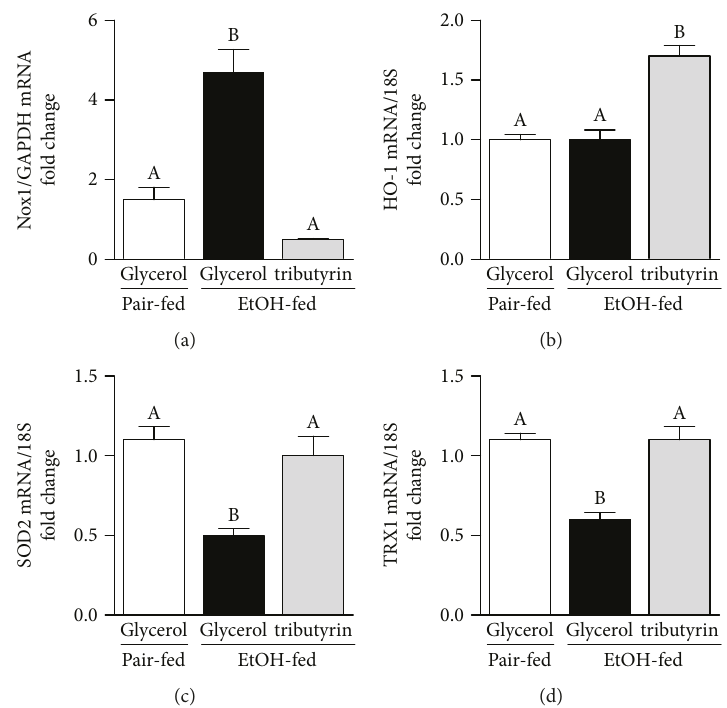
Figure 4: E ff ects of tributyrin on expression of pro- and antioxidant mediators in the proximal colon following chronic-binge ethanol exposure. Mice were treated as described in Figure 1, and the proximal colon was excised and used to prepare RNA. (a – d) Expression of NOX1, HO-1, SOD2, and TRX1 mRNA was detected in the mouse proximal colon using quantitative real-time reverse transcription polymerase chain reaction. Values represent means ± SEM . n = 4 – 6 mice per treatment group. Values with di ff erent alphabetical superscripts were signi fi cantly di ff erent from each other, p < 0 05